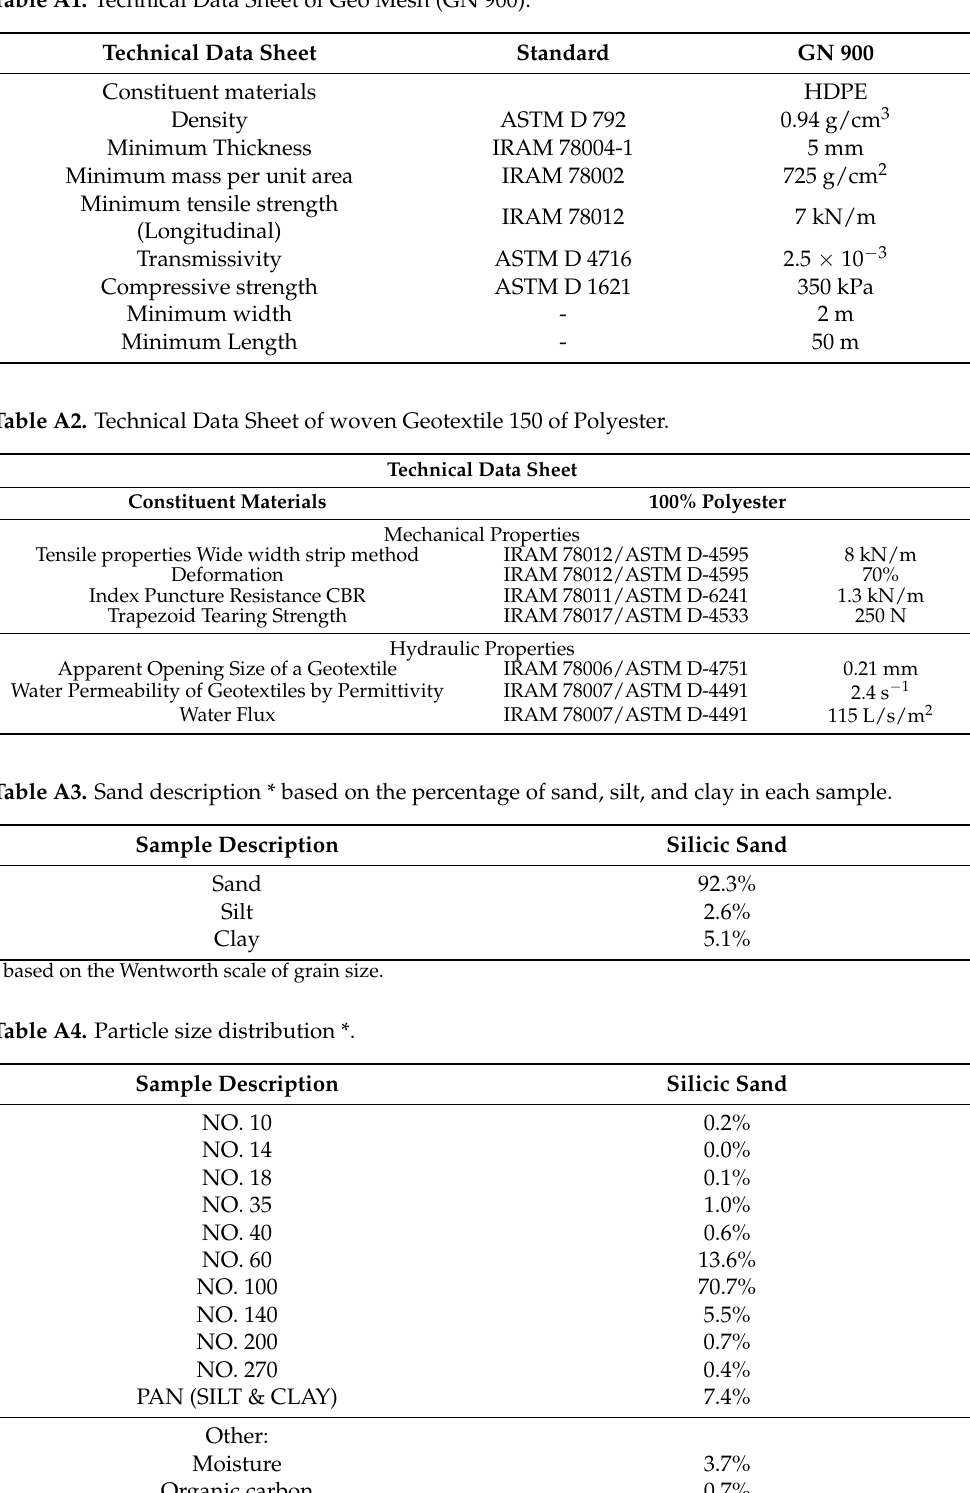
Table A1. Technical Data Sheet of Geo Mesh (GN 900).